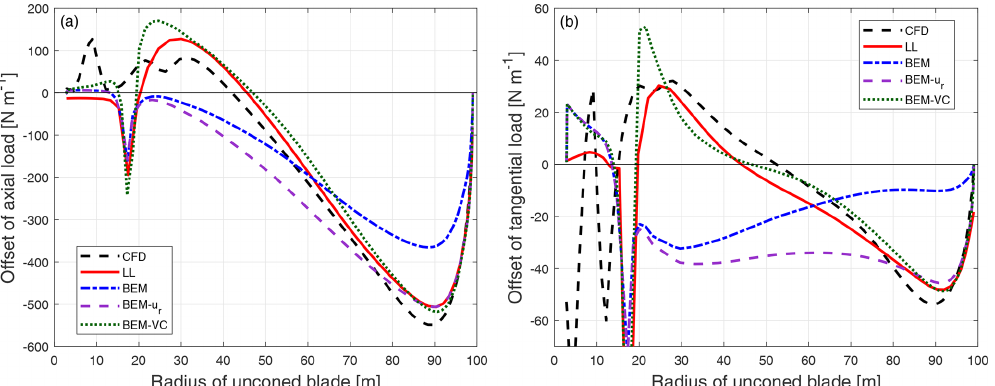
Figure 15. Comparison of the difference of the axial load (a) and tangential load (b) of the baseline blade with 15 ◦ of cone downwind compared to the baseline blade without cone calculated from CFD, the lifting-line method (LL), the BEM method, BEM with radial induc- tion (BEM- u r ) and the proposed BEM-VC method.